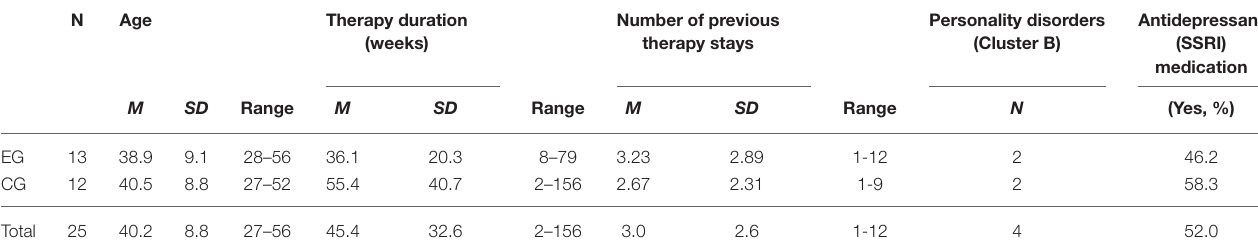
TABLE 1 | Means, standard deviations and percentages of demographic background, treatment history, personality disorders and medication